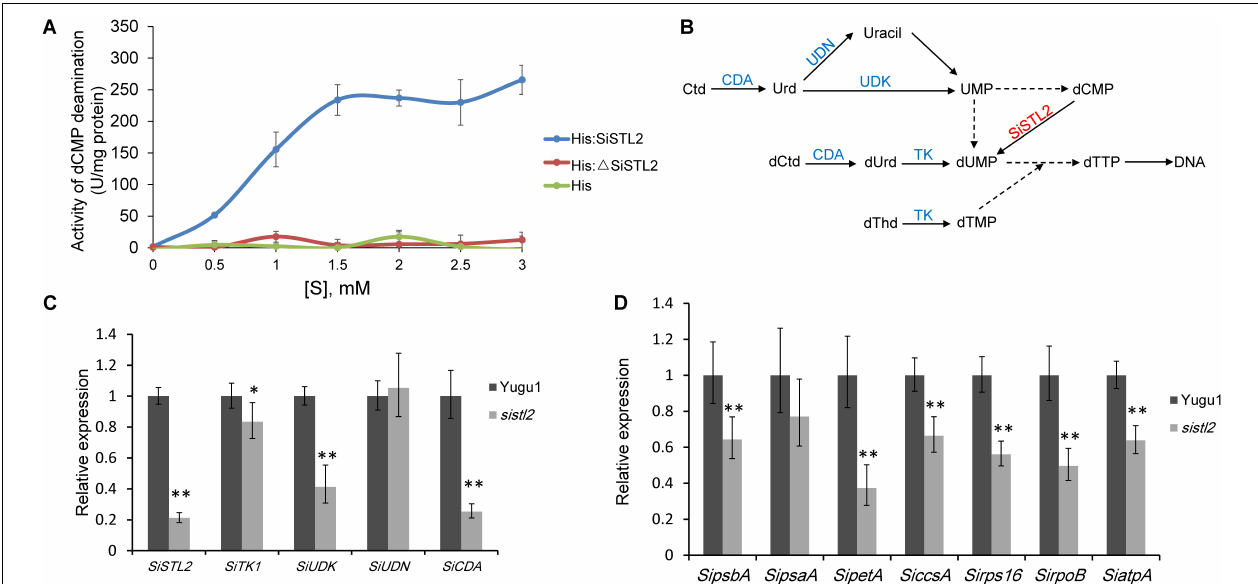
FIGURE 6 | (A) Enzyme activity assay of SiSTL2. One unit of activity refers to deamination of 1 µ M dCMP per minute under the conditions of the assay. The activity of SiSTL2 was determined with increasing concentrations of dCMP. The standard deviations are obtained from three independent assays. (B) The de novo biosynthesis pathway and salvage pathway of dTTP according to previous study (Leija et al., 2016) with several changes based on phytozome database. The DCD homolog SiSTL2 is shown in red and enzymes in salvage pathway are shown in blue. TK, thymidine kinase; UDK, uridine kinase; UDN, uridine nucleosidase; CDA, cytidine deaminase. The dotted lines indicate the abbreviated multi-steps. (C) The relative expression levels of SiSTL2 and pyrimidine triphosphate salvage-associated genes (D) The relative expression levels of chloroplast development-associated genes. SipsbA , encodes PS II protein D1; SipsaA , encodes PS I P700 apoprotein A1; SipetA , encodes cytochrome f; SiccsA , encodes cytochrome c heme attachment protein; Sirps16 , encodes cytochrome c heme attachment protein; SirpoB , encodes RNA polymerase beta subunit; SiatpA , encodes ATP synthase CF1 alpha subunit. The means and standard deviations were obtained from three independent samples. Statistical analysis was performed with t -test. ∗ P = 0.05; ∗∗ P = 0.01.